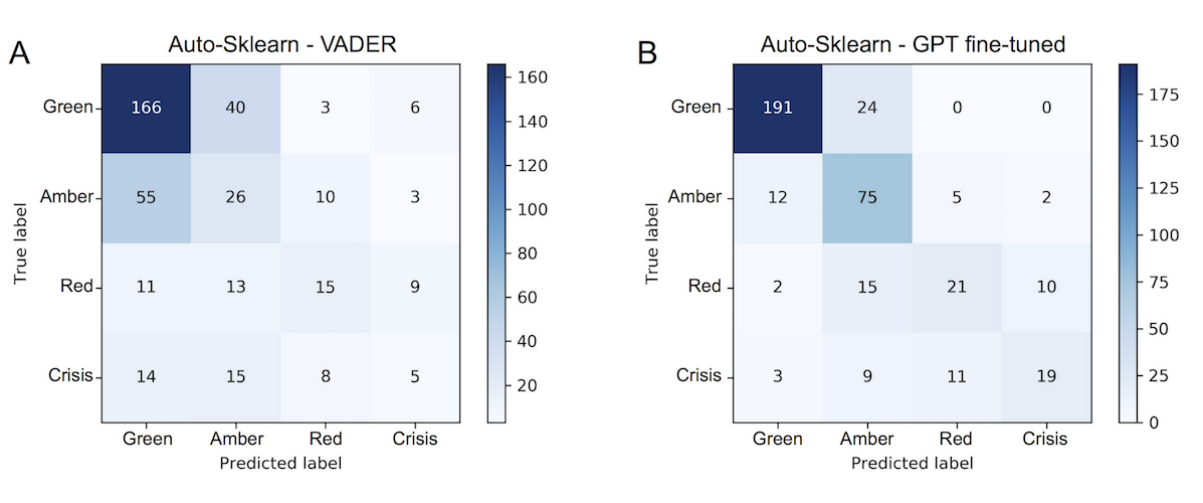
Auto-SklearnTree-based Optimization ToolFeature countFeature set